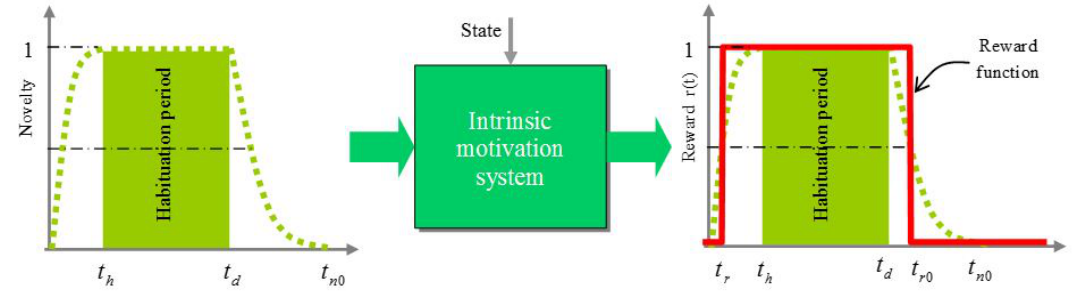
Figure 5: Reward as a function of the intrinsic motivation instigated by novelty.